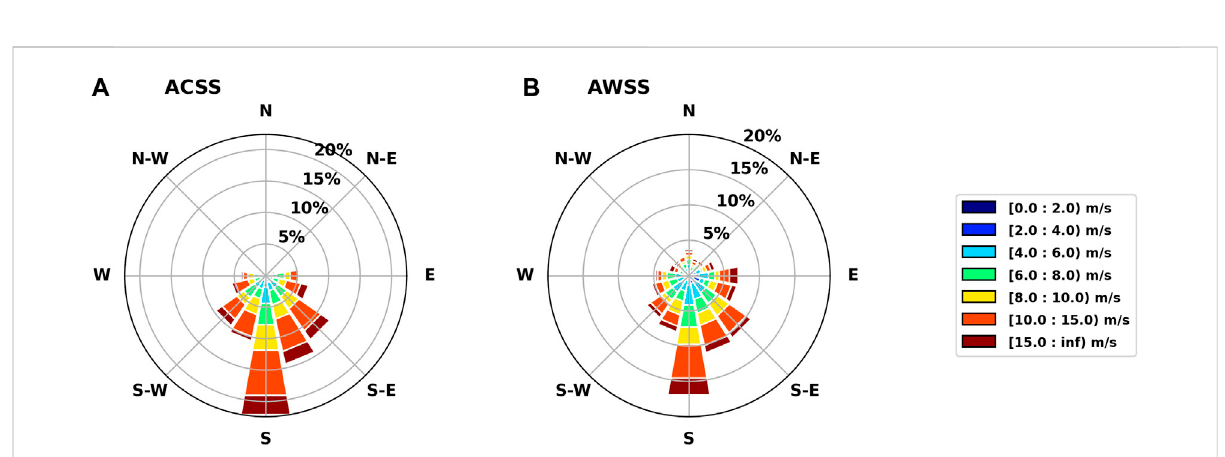
FIGURE 8 Surface wind rose diagrams (%) based on the ICOADS observations during NEP fog in winter (1979 – 2019). (A) Fog during ACSS. (B) Fog during AWSS.